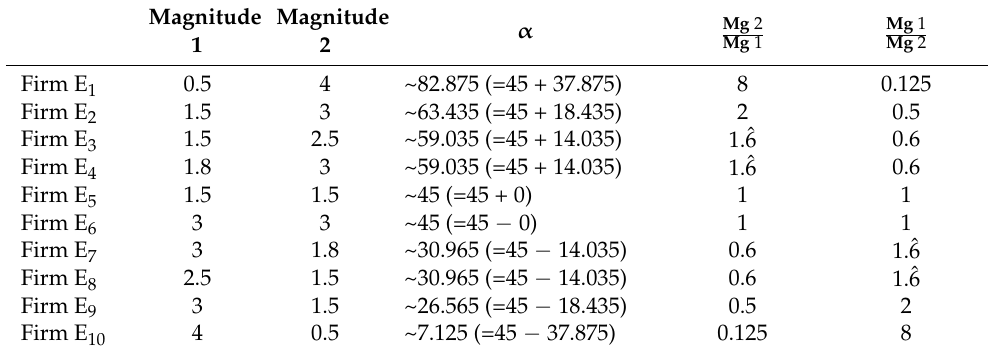
Table 1. Artificial data of a ten-firm